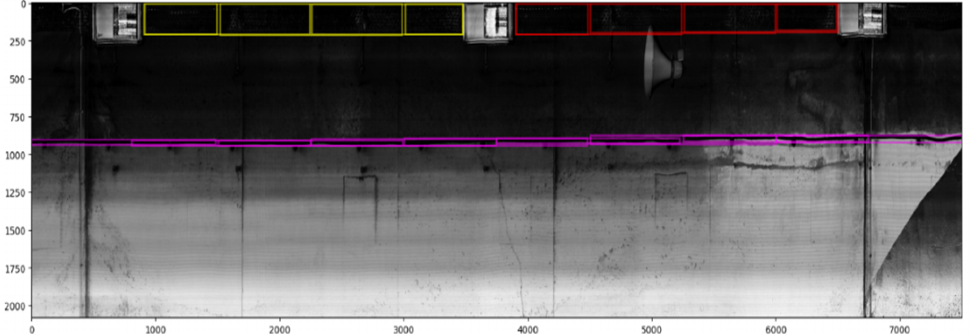
Figure 8. Merging of linear object pieces detected in contiguous